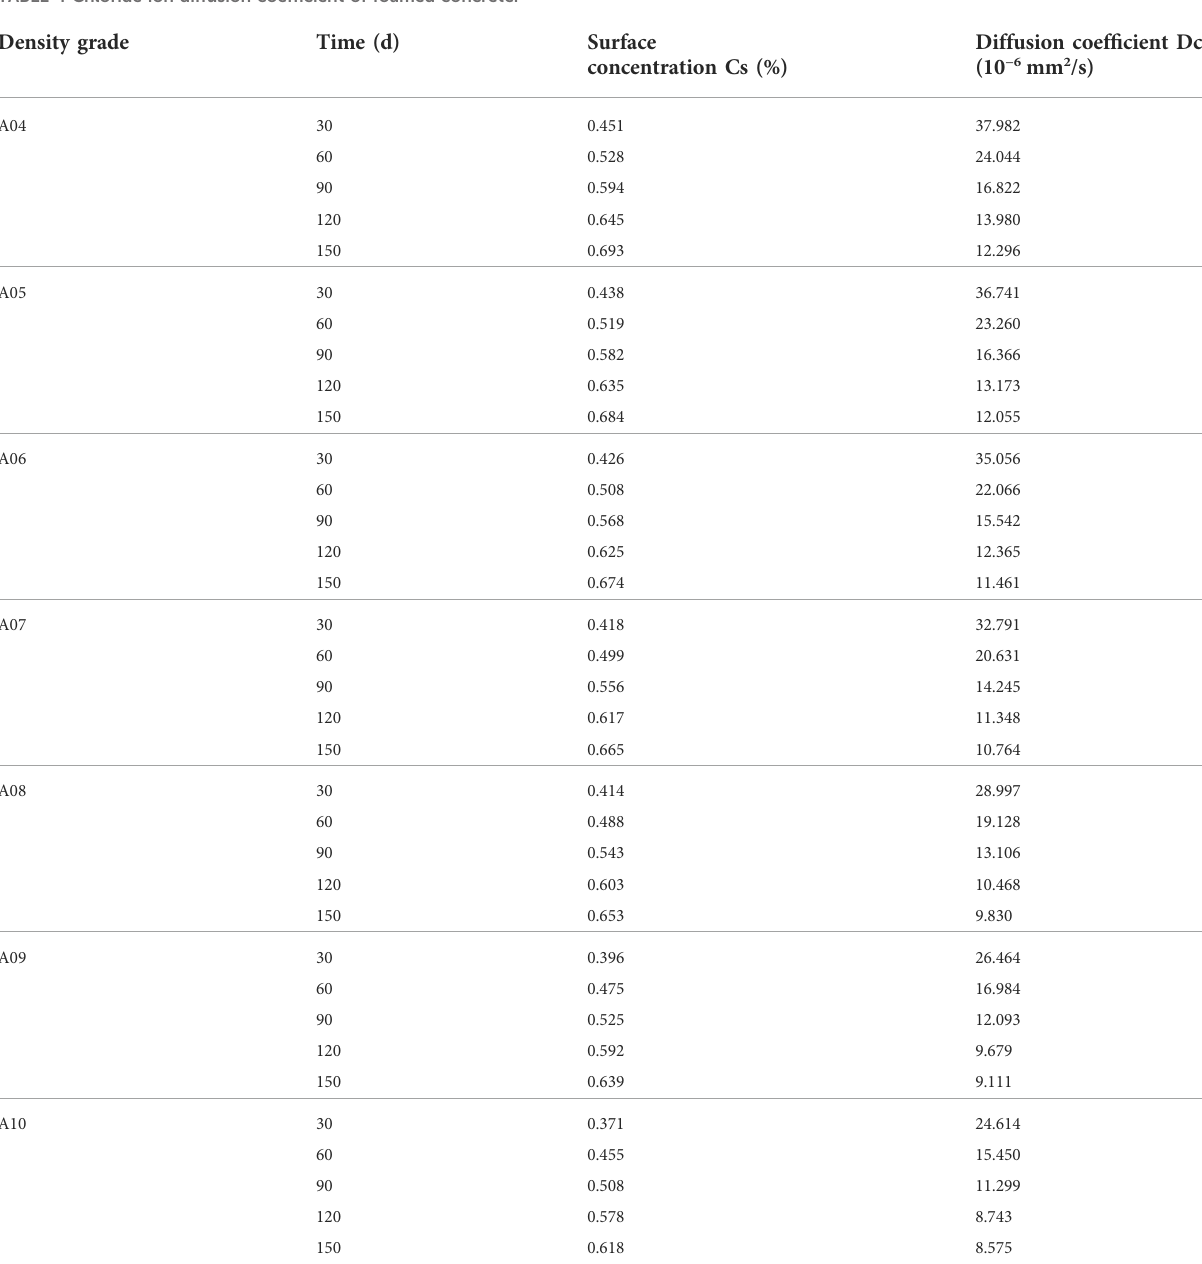
TABLE 4 Chloride ion diffusion coef fi cient of foamed